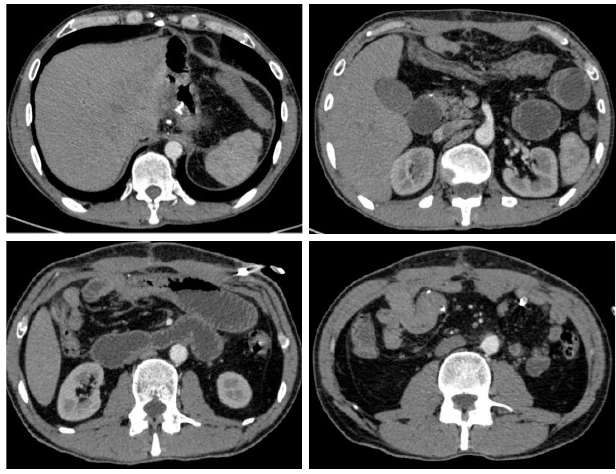
Fig. 1. Plain abdominal radiograph. Fig. 2. Selected axial post-contrast CT images of the